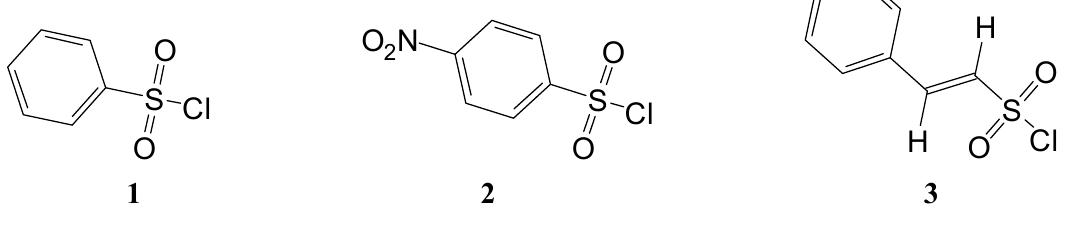
Figure 1. Molecular structures of benzenesulfonyl chloride ( 1 ), p- nitrobenzenesulfonyl chloride ( 2 ), and trans - β -styrenesulfonyl chloride ( 3